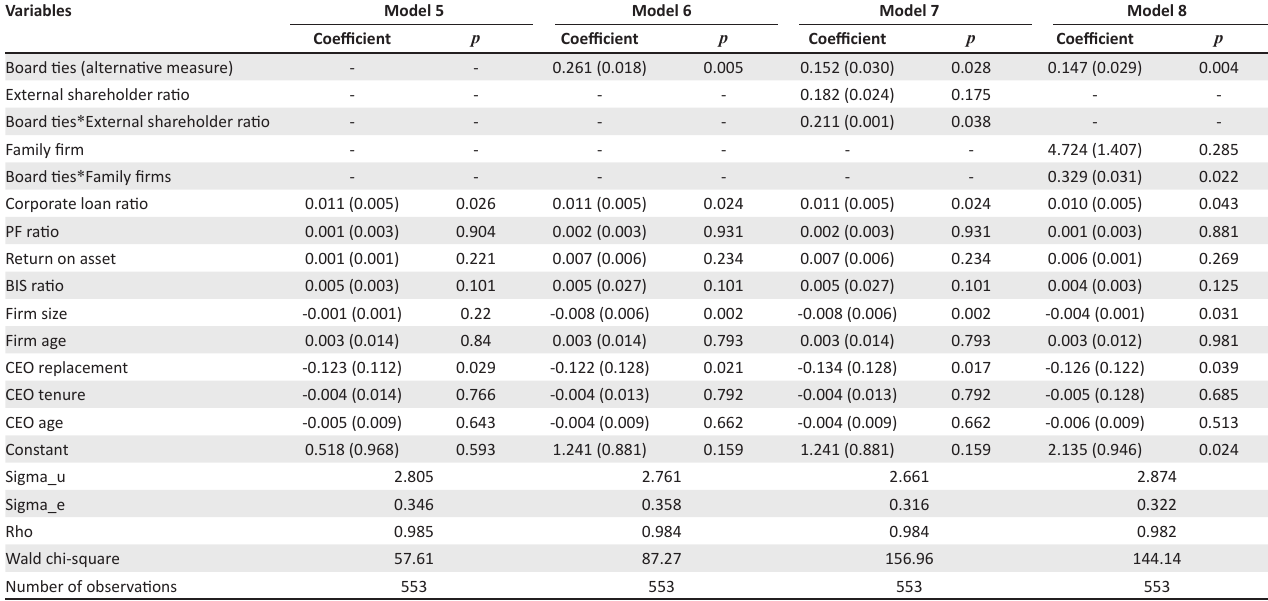
TABLE 3: Alternative test with the different measure of board ties via outside